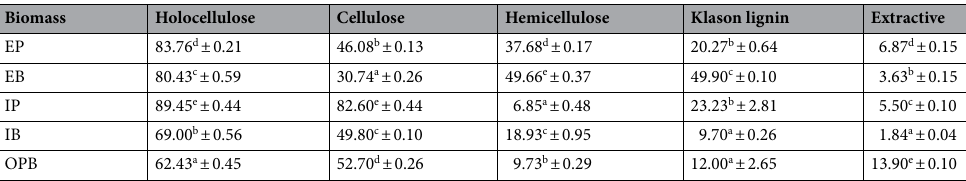
Table 1. Chemical Composition of wild D. bulbifera Biomass (wt% on dry matter). Means ± standard deviation of triplicate determinations. Means within a column with the same superscript letters are not significantly different (p > 0.05) by Duncan’s multiple range test. EP Ekiti peels of Dioscorea bulbifera, EB Ekiti bulbils of Dioscorea bulbifera, IP Isarun peels of Dioscorea bulbifera, IB Isarun bulbils of Dioscorea bulbifera, OPB Ondo peels and bulbils of Dioscorea